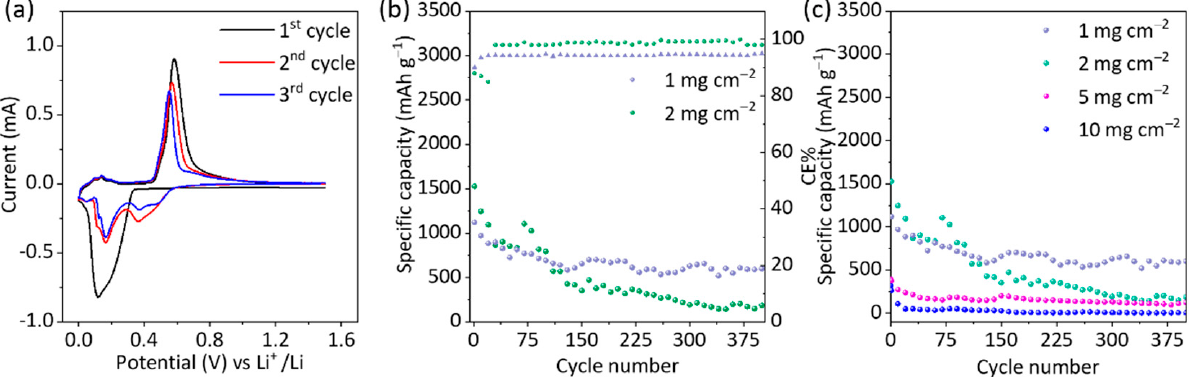
Figure 2. ( a ) CV of 2D α -Ge 1 mg cm − 2 semi-cell at 0.1 mV s − 1 , 25 ◦ C, first three cycles. ( b ) GCD at constant current rate 0.5 C over 400 cycles for 2D α -Ge 1 mg cm − 2 semi-cell (purple dots) and 2D α -Ge 2 mg cm − 2 semi-cell (green dots). ( c ) GCD at constant current rate 0.5 C over 400 cycles for 2D α -Ge 1 mg cm − 2 semi-cell (purple dots), 2D α -Ge 2 mg cm − 2 semi-cell (green dots), 2D α -Ge 5 mg cm − 2 semi-cell (pink dots) and 2D α -Ge 10 mg cm − 2 semi-cell (blue dots).